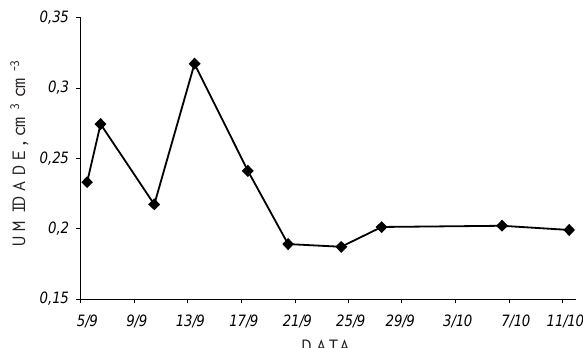
Figura 3. Umidade do solo nas datas de coleta das espumas.